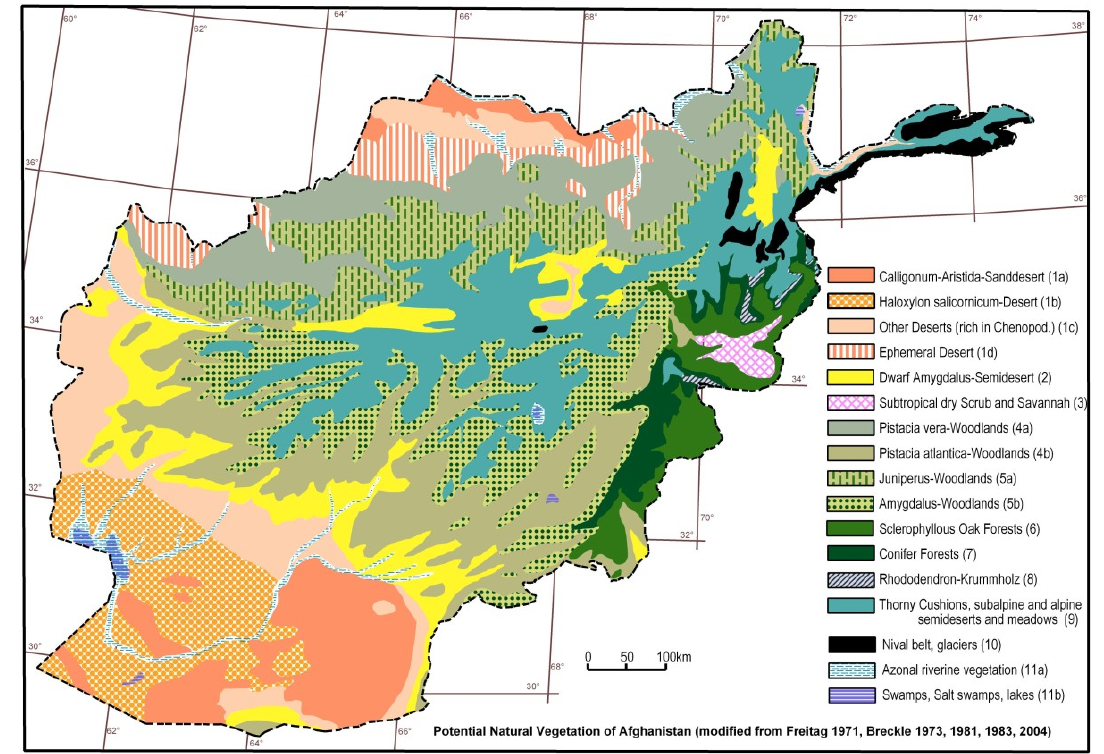
Figure 2. The natural vegetation of Afghanistan ( adapted from [49] ).